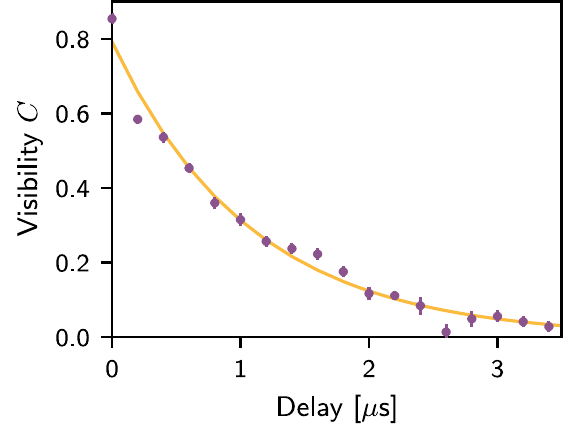
FIG. 10. Hahn echo after optimal purification. Hahn-echo visibility versus delay (purple circles) is fitted with an exponential decay (yellow curve) to extract a T HE 2 ¼ 1 . 10 ð 9 Þ μ s.